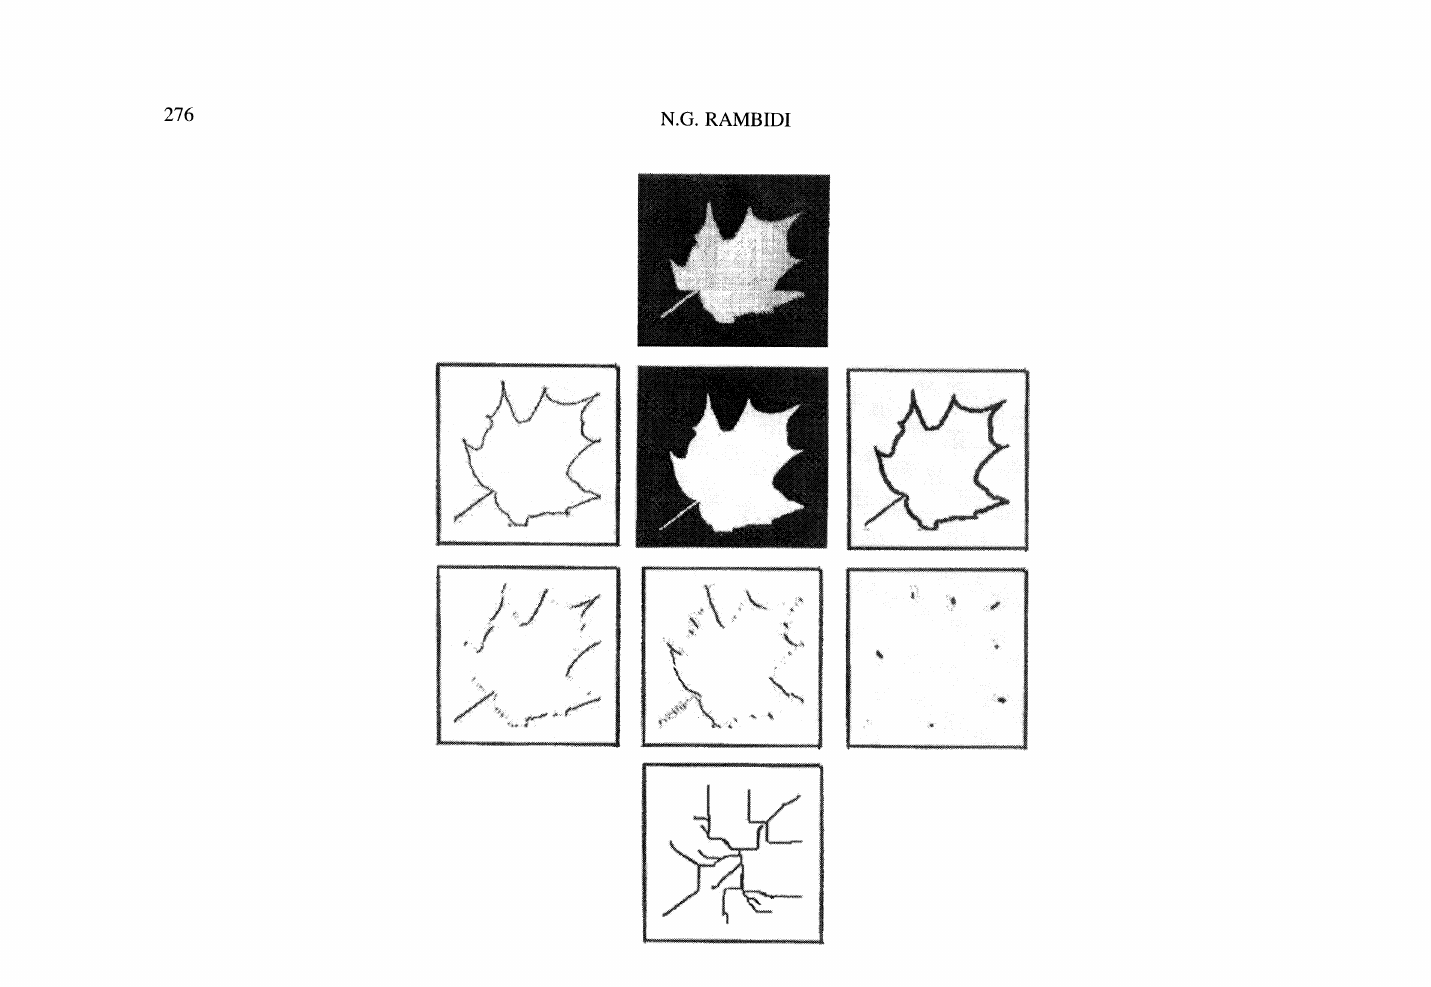
in upper part contour,